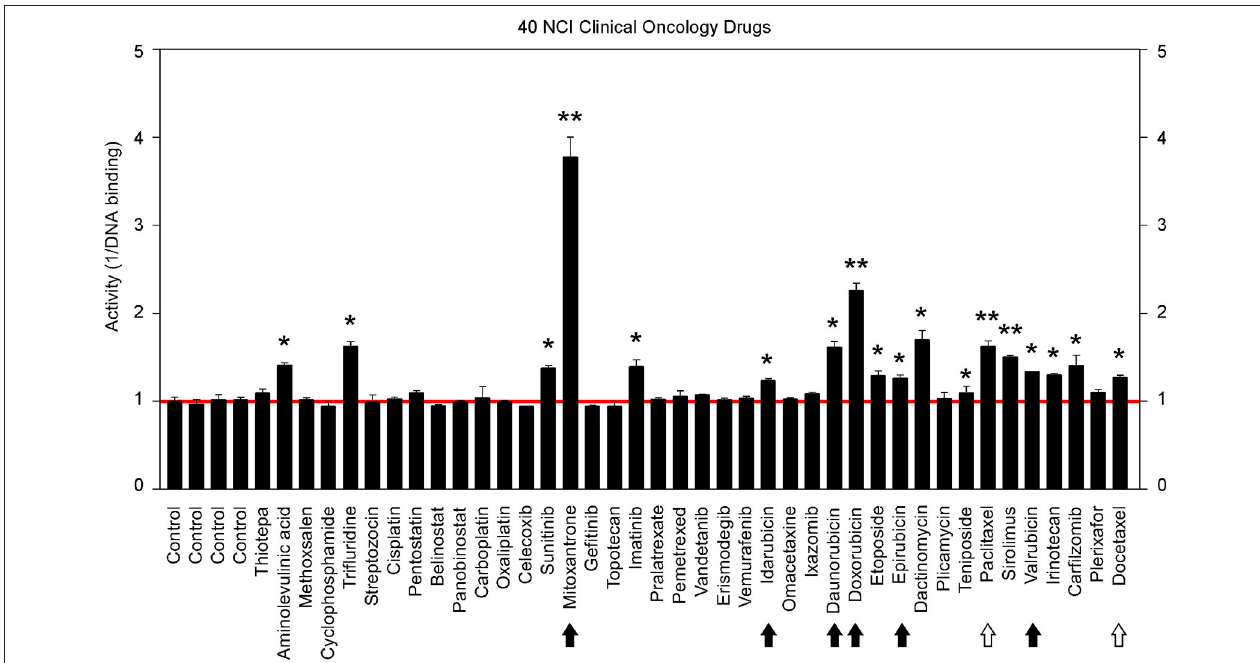
FIGURE 4 | Clinical oncology drugs inhibit GT198. Clinical oncology drugs were tested by the DNA binding assay. The drug activities of GT198 inhibition are shown as the relative reciprocal amounts of DNA binding in a bar graph. Black arrows indicate doxorubicin analogs. White arrows indicate paclitaxel analogs. Stars indicate statistically significant activities. Selected 40 oncology drugs are shown, and the complete list is in Supplementary Table 1